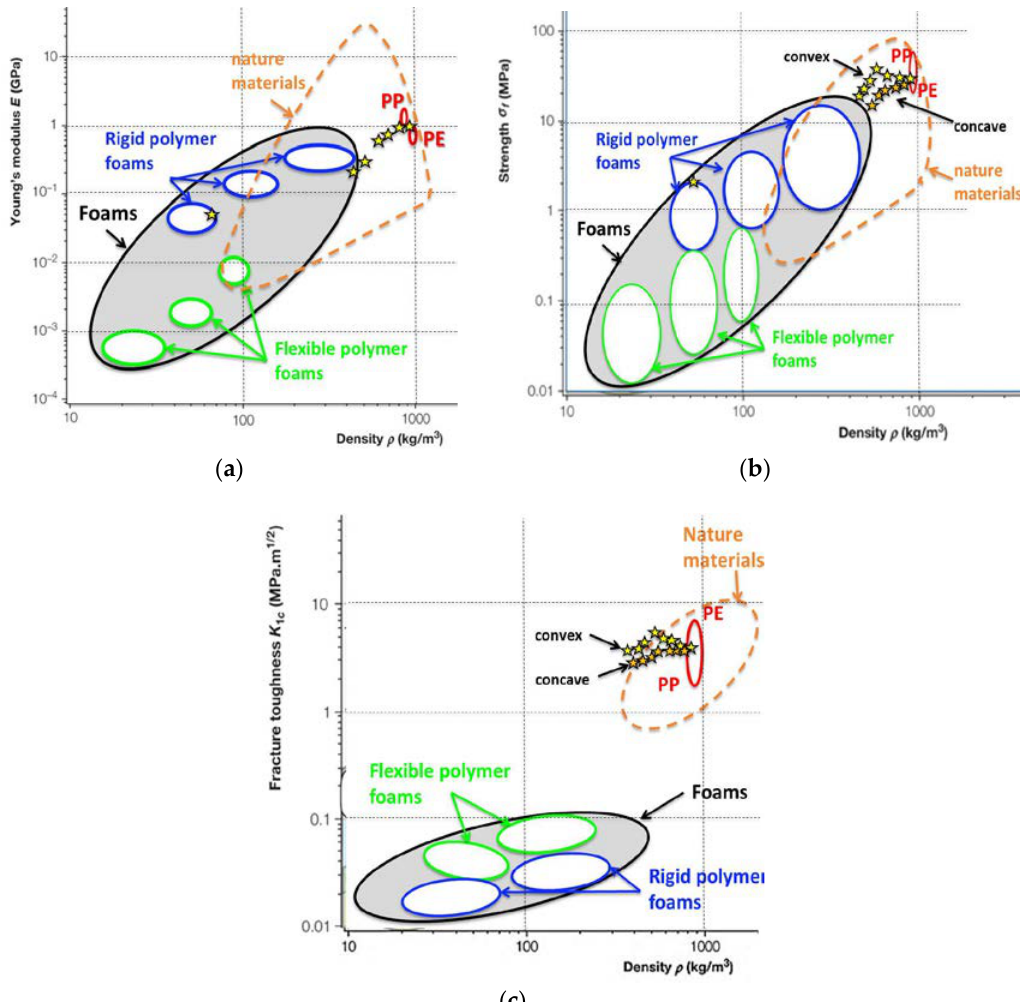
Figure 11. Ashby plots of the static mechanical properties versus the average density: ( a ) the Young modulus, ( b ) the tensile strength, and ( c ) the critical stress intensity factor. Stars represent experimental data obtained in this work. The Young ′ s modulus data for convex and concave density gradients coincided due to the logarithmic scale of the vertical axis.